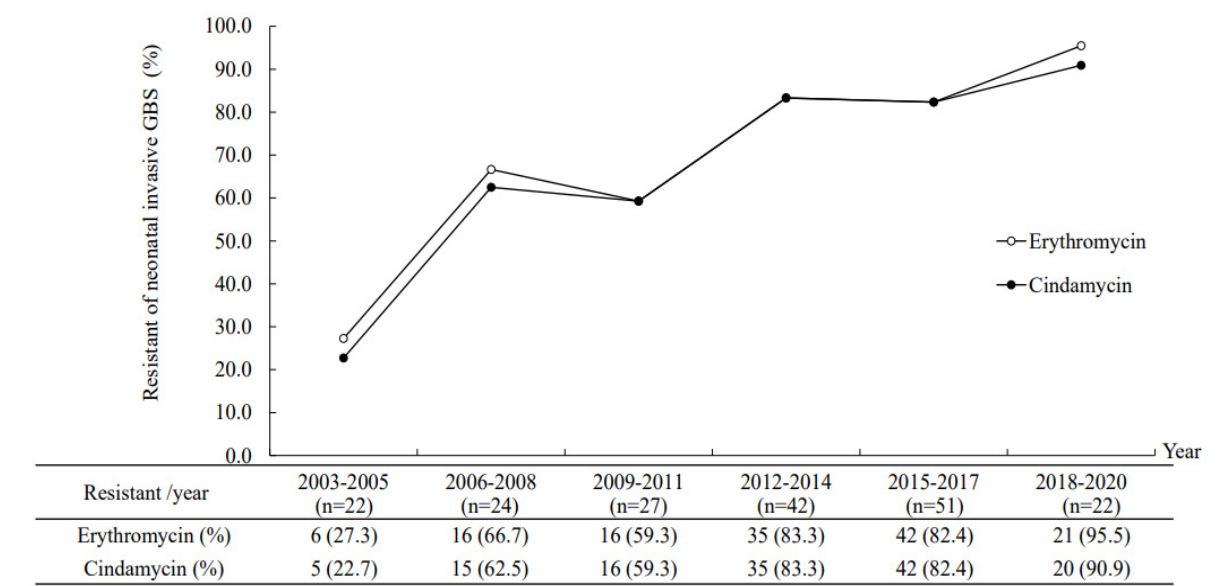
Figure 4. The increasing antimicrobial resistance to erythromycin and clindamycin in 188 invasive group B streptococcal isolates from 2003 to 2020. Table 1. Patient demographics of neonatal invasive group B streptococcus (GBS) infections in Chang Gung Memorial Hospital (CGMH).